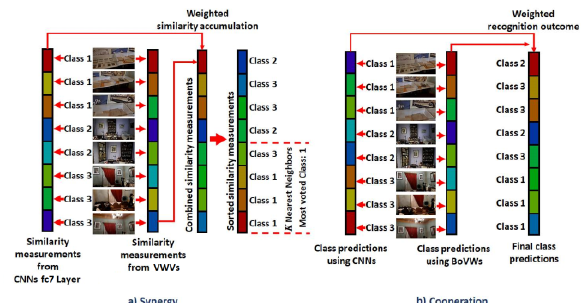
Figure 2. Synergy (a) and cooperation (b) operational schemata of the hybrid recognition